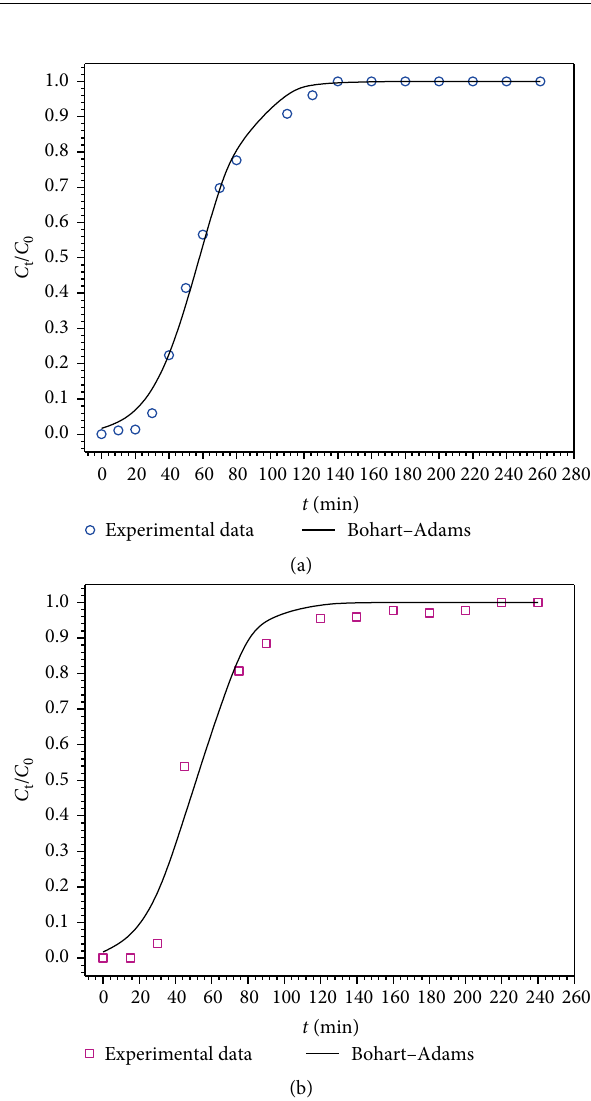
Figure 6: Breakthrough curves for experiment 7 of the 2 2 experimental design modeled by the Bohart-Adams original model for adsorption of (a) Cu 2+ and (b) Co 2+ on SBox adsorbent in a fixed- bed column at